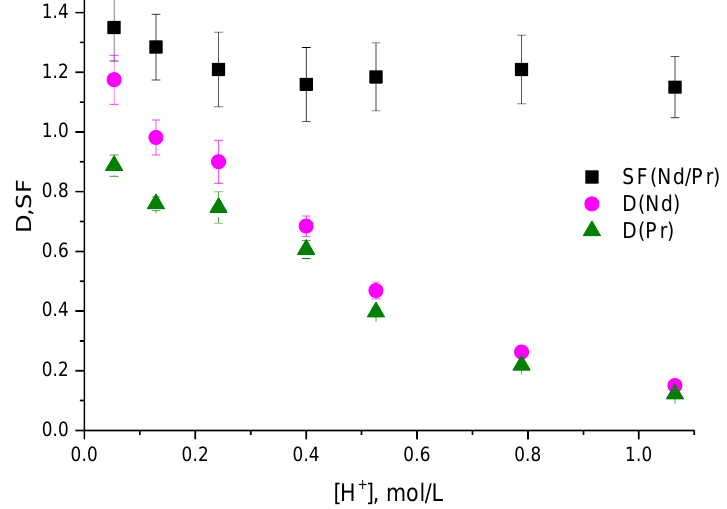
Figure 2. Distribution ratios and separation factors for Nd(III) and Pr(III) in the system “1 mol∙L −1 HDEHP in dodecane —50 g∙L −1 REE(NO 3 ) 3 + HNO 3 ” .